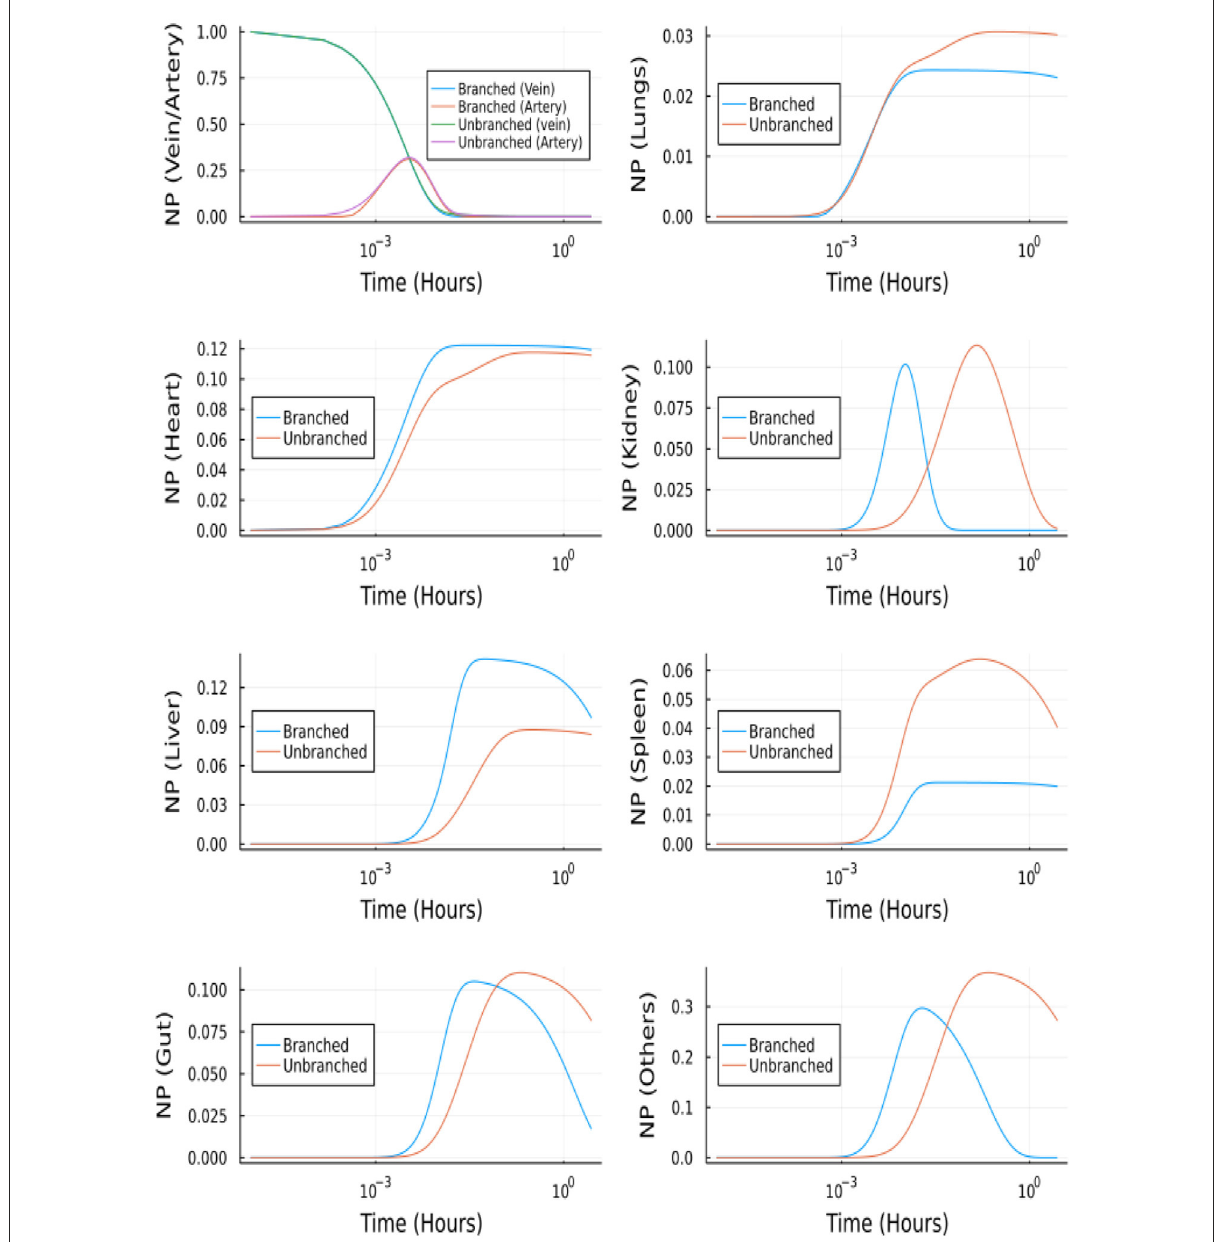
FIGURE10 NP concentration vs. Time for the branched and unbranched models: For the organs which have ϕ > 1 the onset is quicker. For lungs ϕ ∼ 1 and for spleen ϕ < 1 .